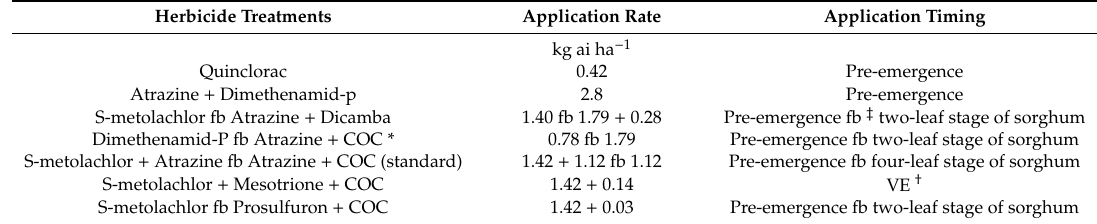
Table 3. Herbicide treatments, their application rate, and application timing used in this